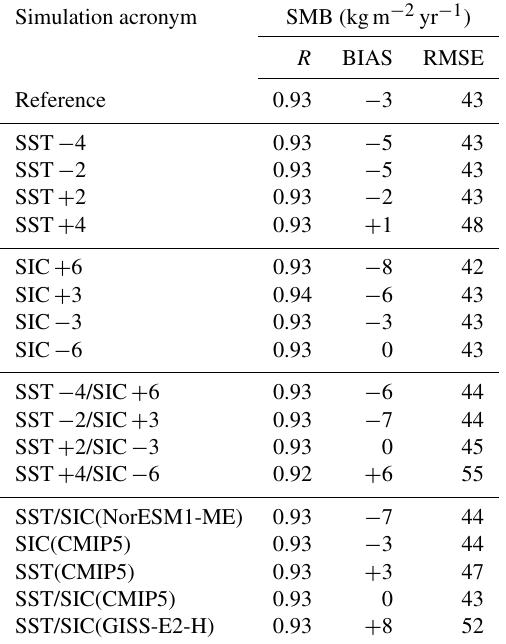
Table 3. Comparison between modelled and observed SMB from the GLACIOCLIM-SAMBA database (Favier et al., 2013) over 1950–2015. Bias and RMSE units are kgm − 2 yr − 1 . The observa- tion mean is 65kgm − 2 yr − 1 , while the observation standard devia- tion is 119kgm − 2 yr − 1